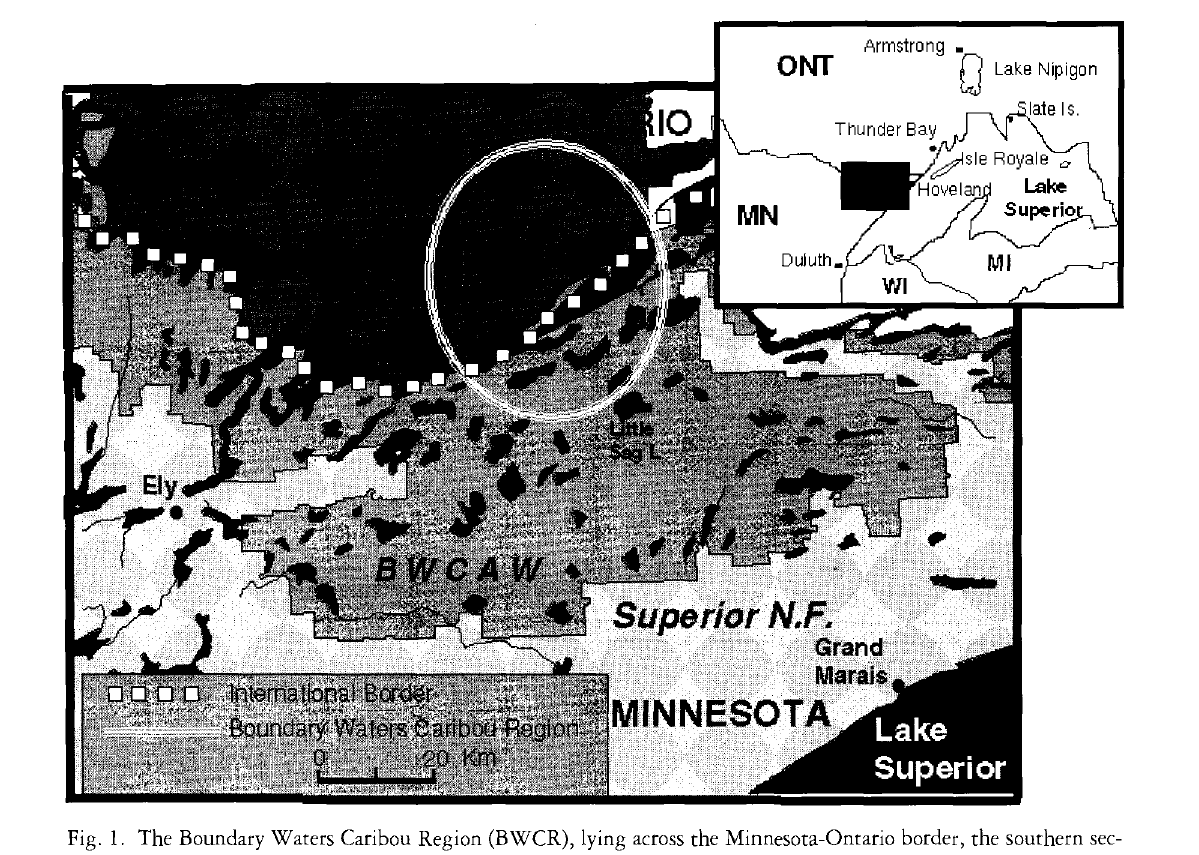
Fig. 1. The Boundary Waters Caribou Region (BWCR), lying across the Minnesota-Ontario border, the southern sec- tot being within the Boundary Waters Canoe Area Wilderness (BWCAW) of the Supetiot National Forest and the northern sector within Quetico Provincial Park. The 1300-km 2 BWCR represents the estimated con tiguous zone of favorable habitat fot